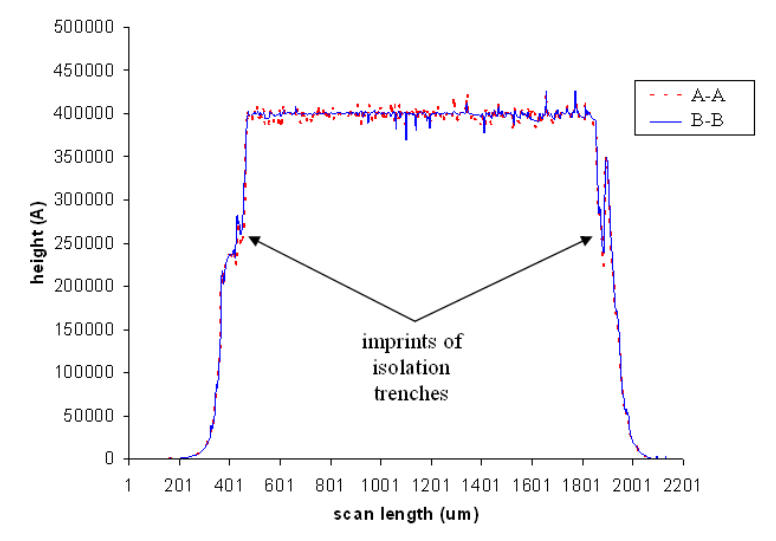
Figure 7. Tencor surface profiler scan across sections A-A and B-B of Figure 5.